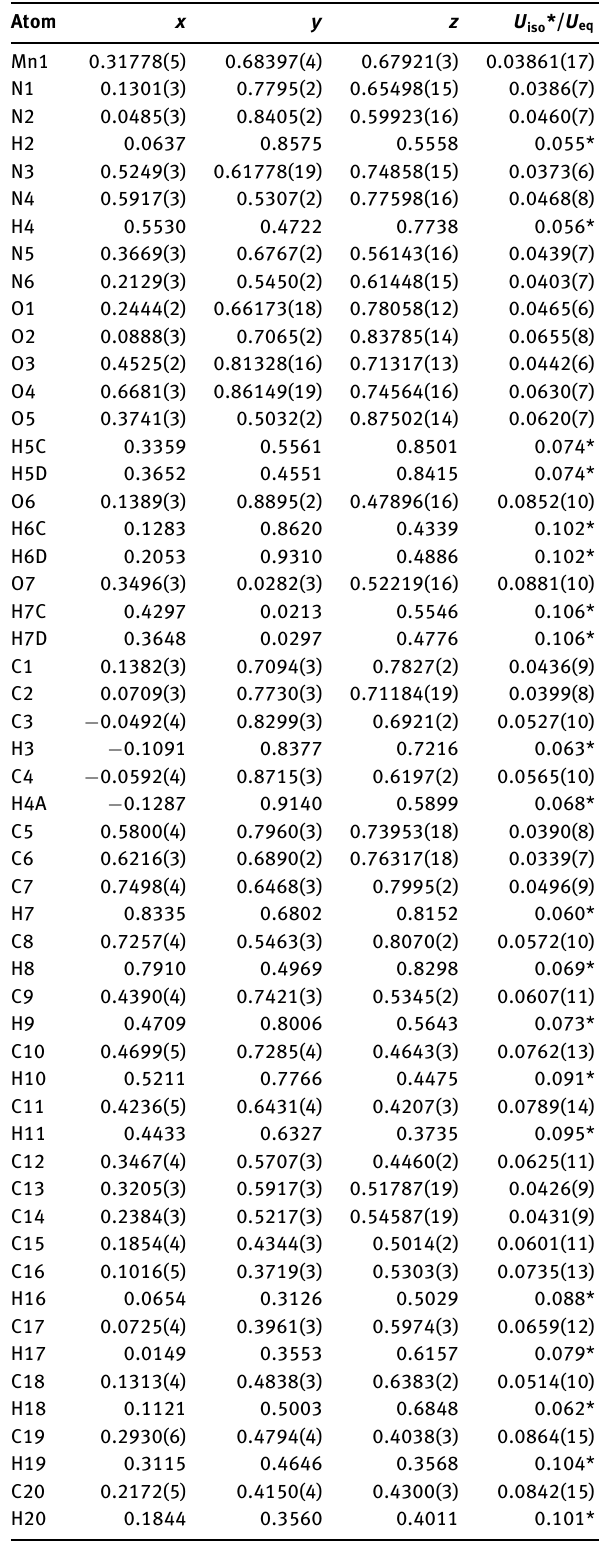
Table 2: Fractional atomic coordinates and isotropic or equivalent isotropic displacement parameters (Å 2